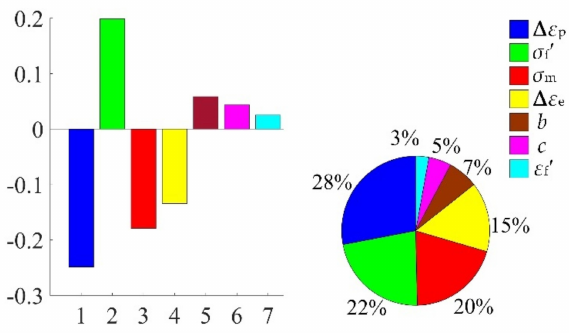
Figure 20. Sensitivities and e ff ect probabilities of fatigue life.